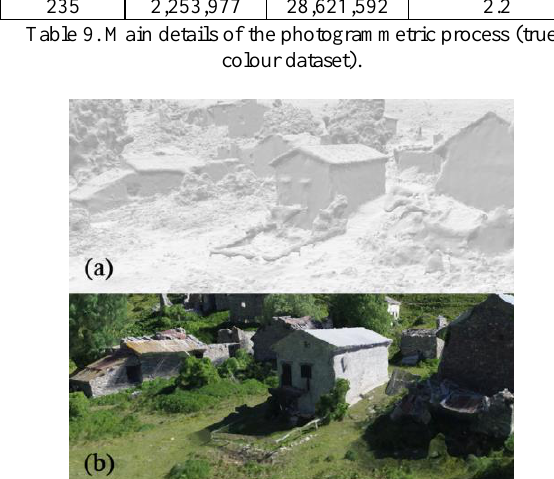
Figure 12. (a) Mesh triangulated from true colour dataset and (b) Texturized mesh (optical data).